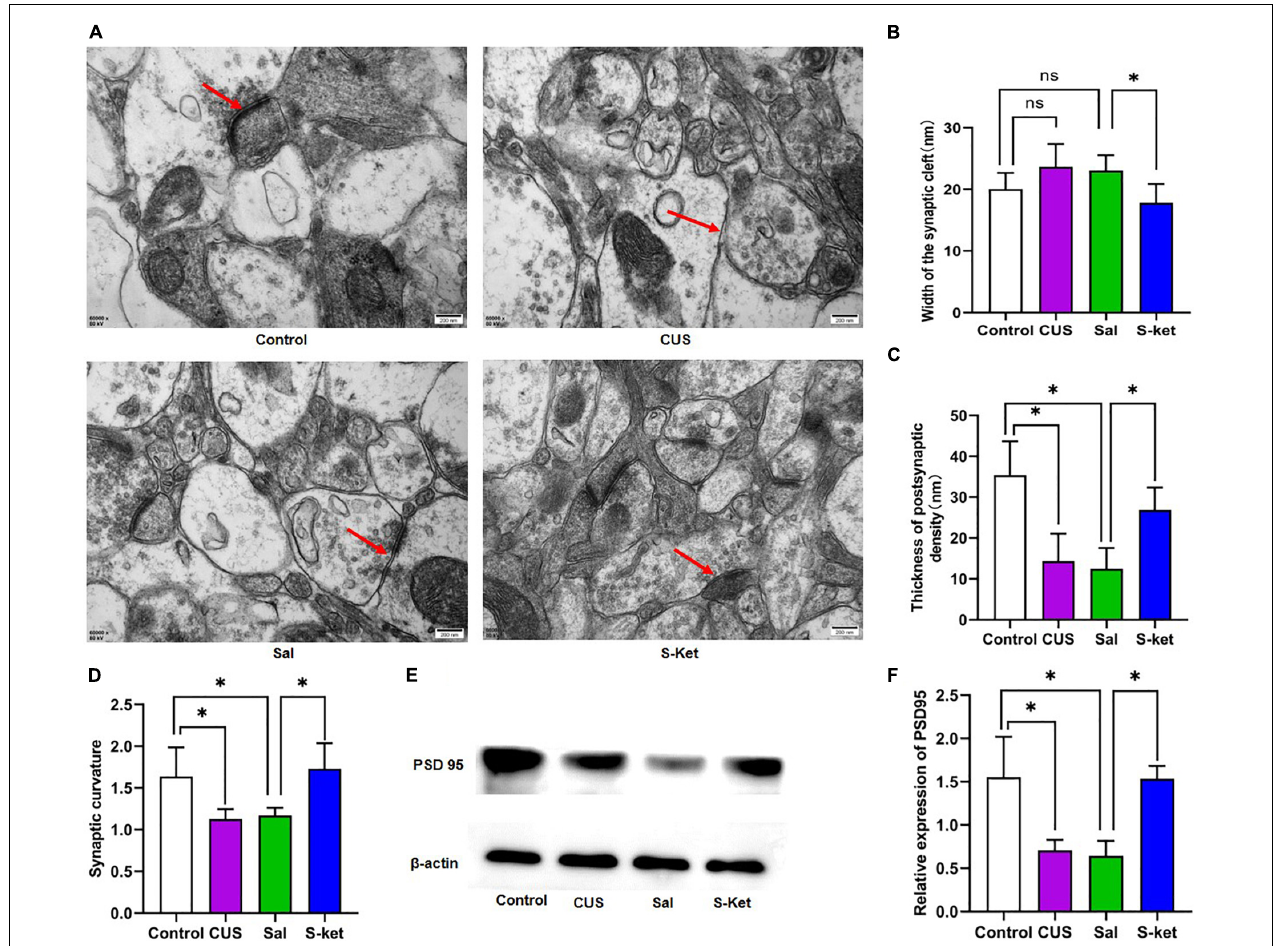
FIGURE 2 | S-ketamine changed the synaptic ultrastructure in mPFC. (A) Synaptic ultrastructure of mPFC under × 60,000 magnification. The red arrow represents a typical structure. (B) Synaptic cleft width of mPFC ( n = 3). (C) Thickness PSD of mPFC ( n = 3). (D) Synaptic curvature of mPFC ( n = 3). (E) Bands of PSD95 obtained from the Western blot test ( n = 3). (F) Relative expression of PSD95 protein. The data are expressed as the mean ± standard error, and ∗ P <